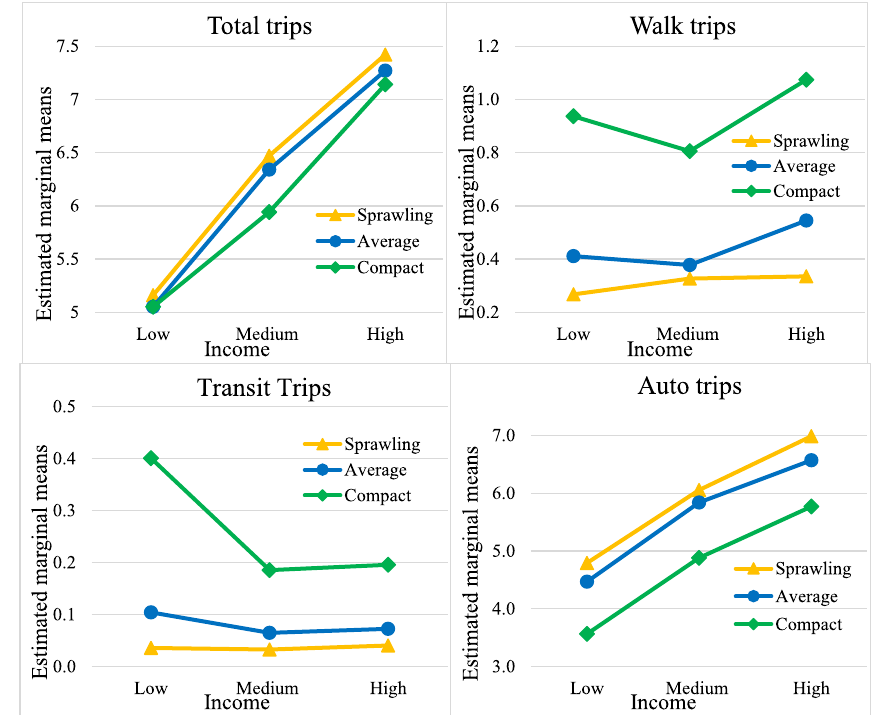
Fig. 3 Means (of numbers of trips per household per day) plot of the two-way ANOVA test for the effects of income and built environment on older adults’ travel